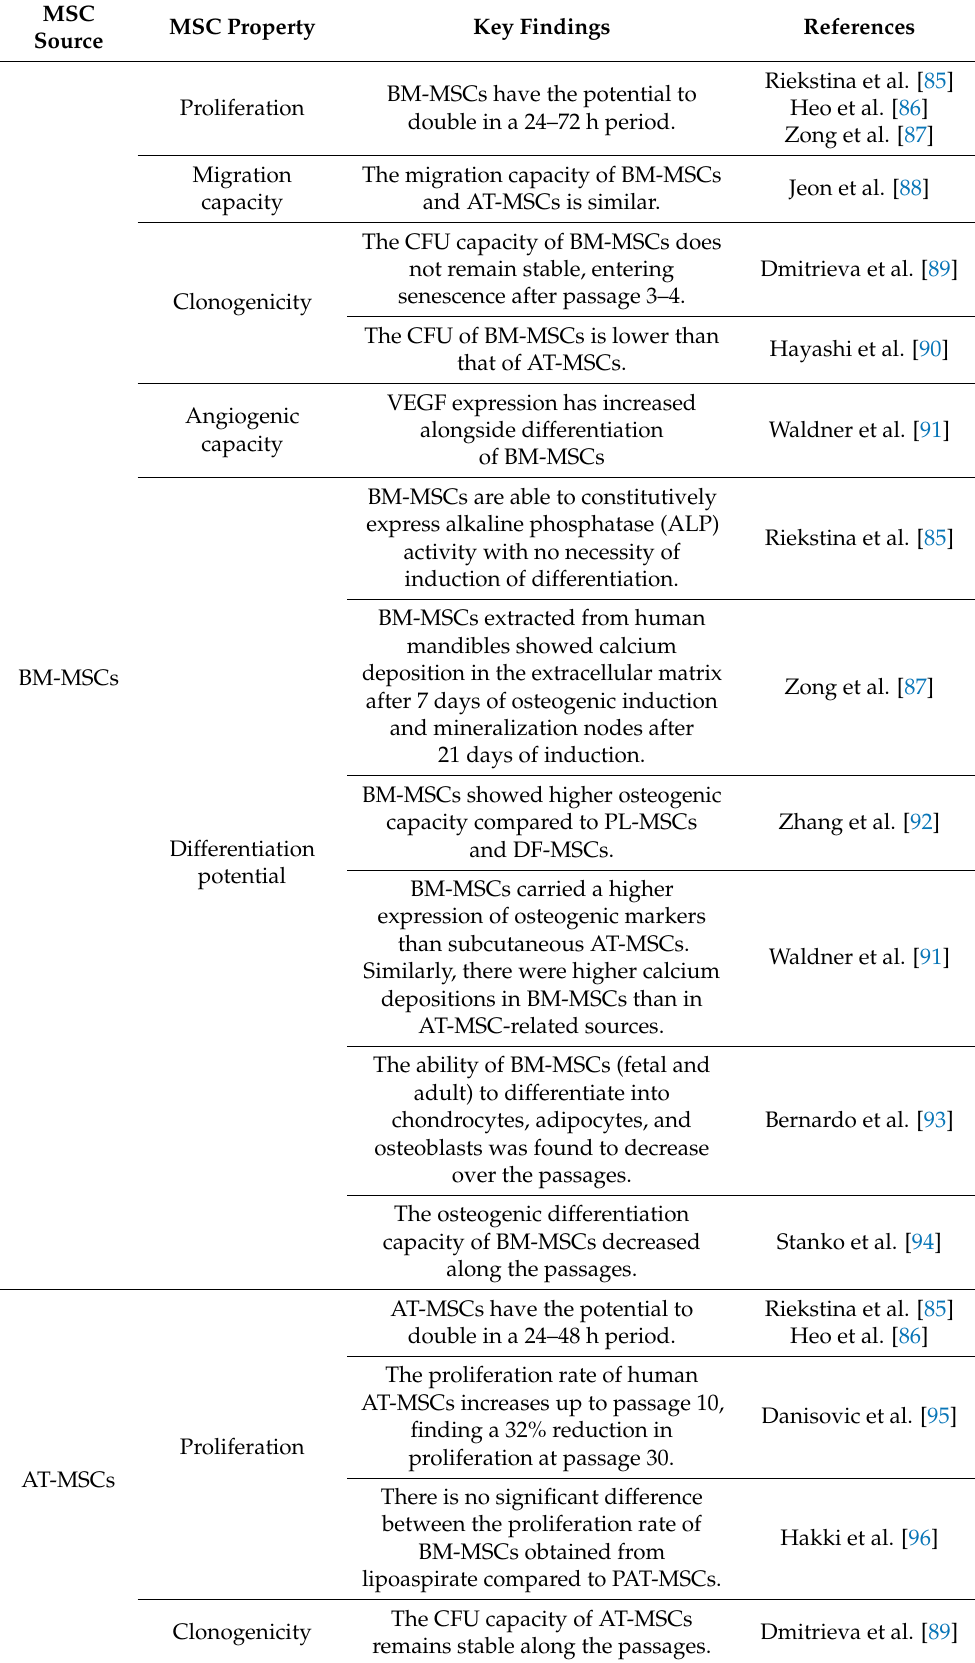
Table 2. Key findings of the MSC Properties in relation to the